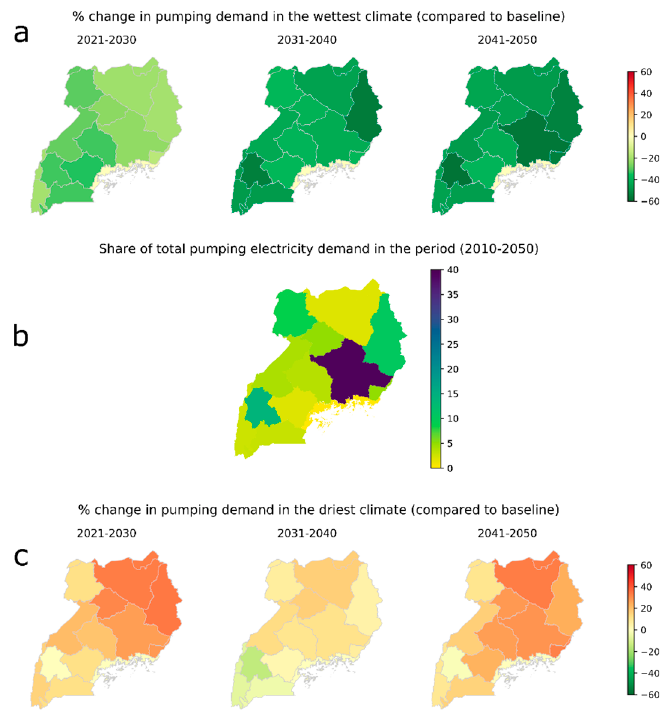
Figure 12. Pumping electricity demand. ( a ) The decadal average of the change in pumping demand in the cumulatively wettest future when compared to the baseline. ( c ) The decadal average of the change in pumping demand in the cumulatively wettest future when compared to the baseline. ( b ) Catchment specific share of the cumulative pumping demand in the country.